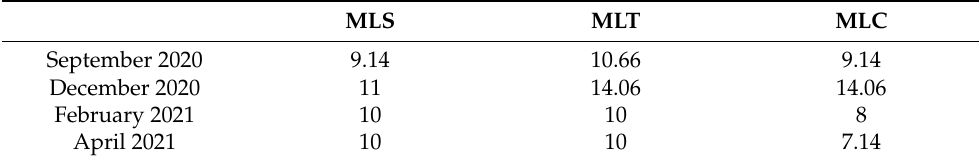
Table 4. Picture description.